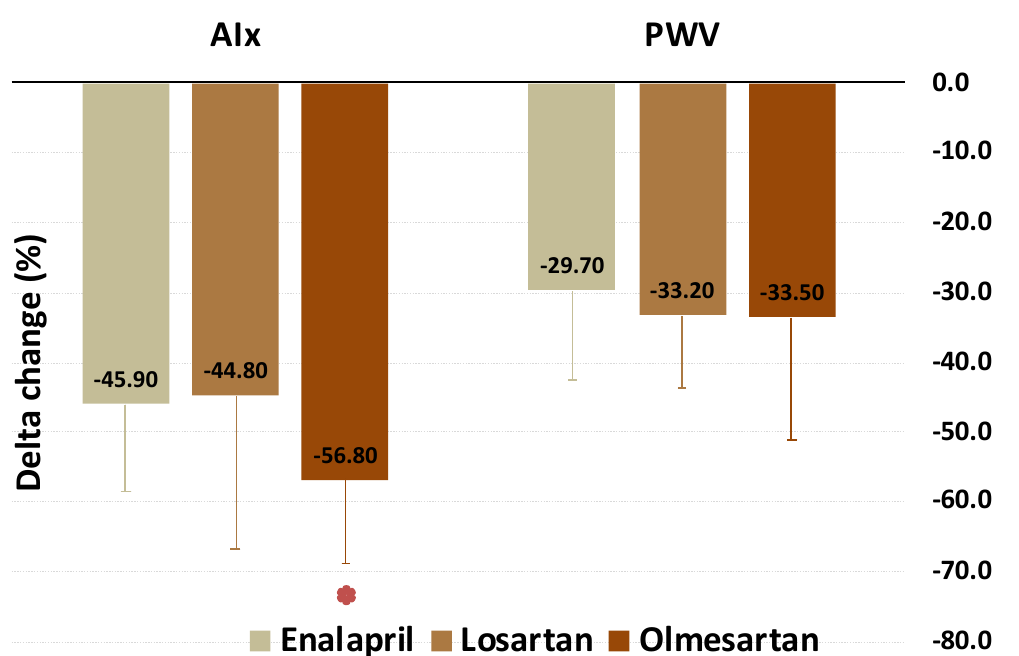
Figure 4. Change (%) of AIx and PWV by treatment with enalapril, losartan, and olmesartan. * Best, vs. both enalapril and losartan.